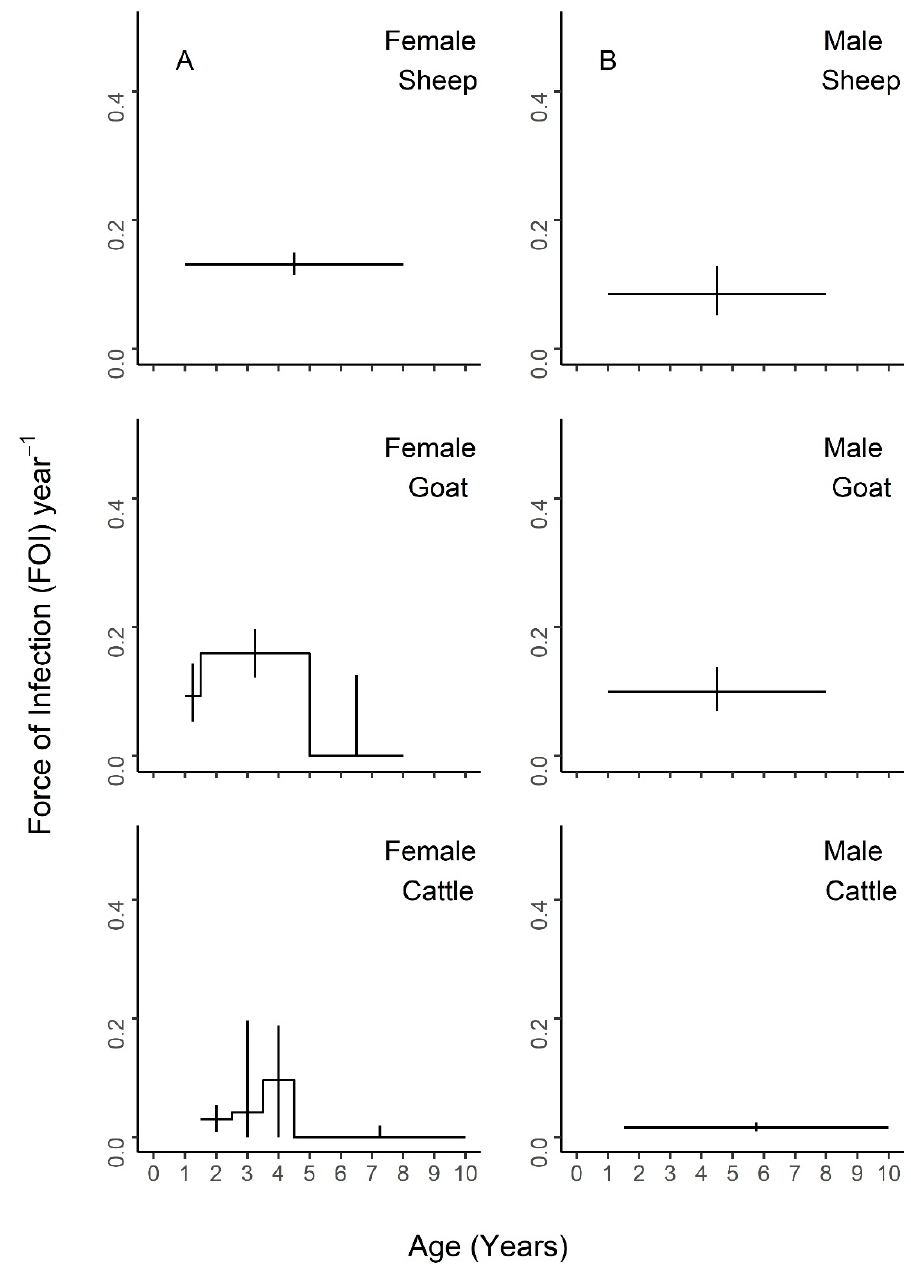
Figure 5. Age-varying force of infection models are a better fit for female goats and cattle than constant models for PPRV transmission by species and sex. Age-specific force of infection estimates and profile confidence intervals from the best fit models for each species from a piece-wise catalytic model, stratified by sex. A ) Females B ) Males .